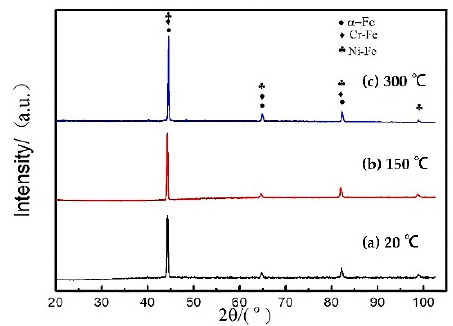
Figure 3. XRD image of different preheating temperatures.